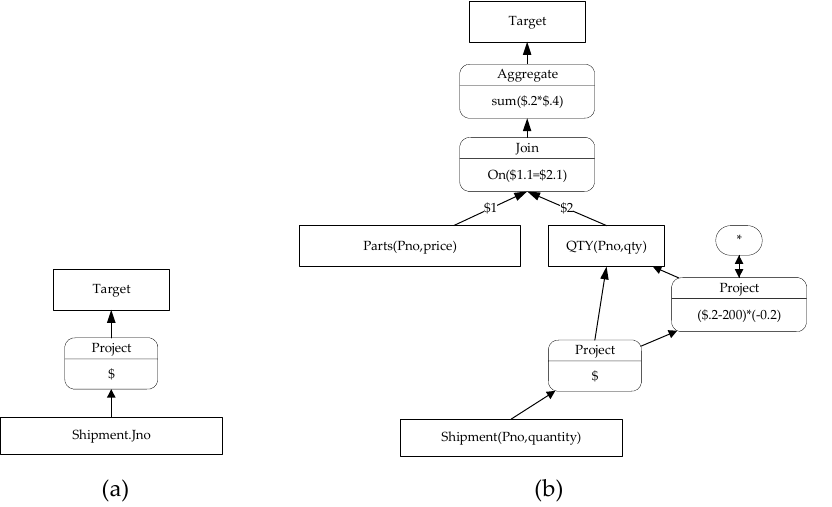
Figure 8. The field provenance graphs of the query Q 2 . ( a ) and ( b ) correspond to FPGraph ( Q 2 . Jno ) and FPGraph ( Q 2 . sm ) , respectively.